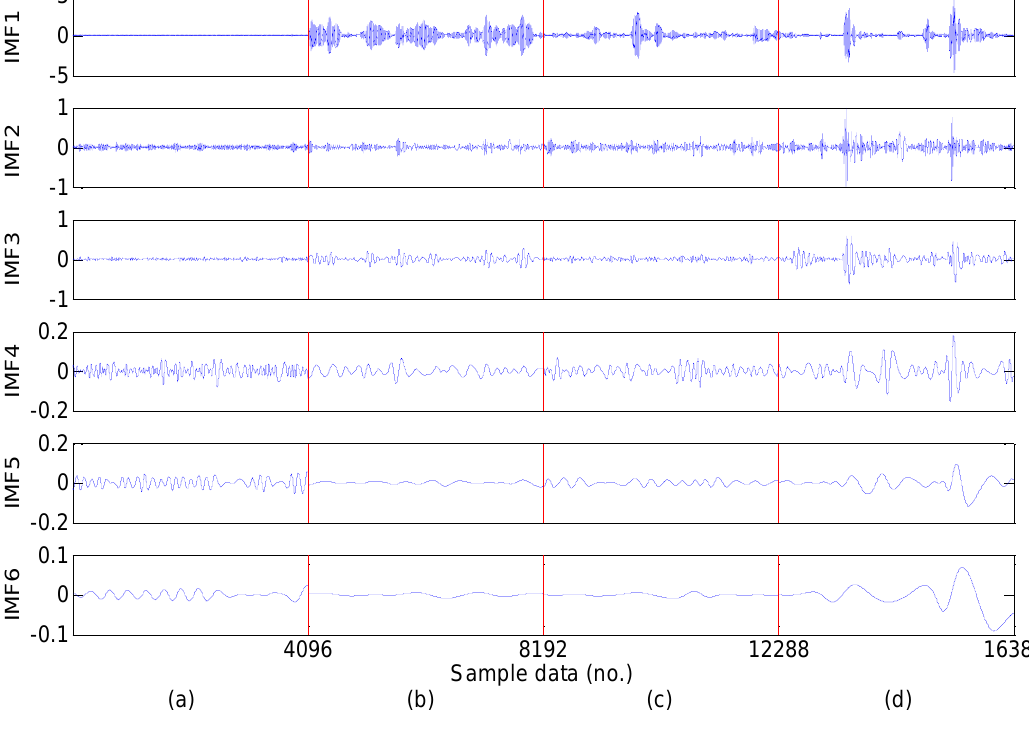
Figure 8. The first six IMFs obtained by applying EMD method to a signal sample in the dataset: ( a ) Normal; ( b ) Inner race fault; ( c ) Ball fault; ( d ) Inner race fault (Note: sample data No. 1–4096, 4097–8192, 8193–12288, 12289–16384 represent normal, inner race fault, ball fault and outer race faults,